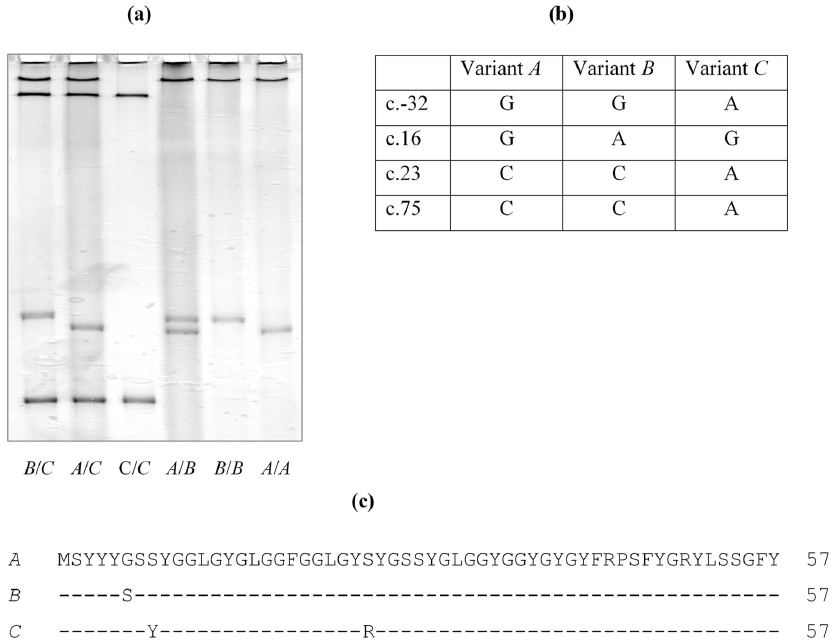
Figure 3. Polymorphism of ovine KRTAP36-1 . ( a ) Three variants ( A to C ) in either homozygous or heterozygous forms were detected by PCR-SSCP. ( b ) Four single nucleotide polymorphisms (SNPs) were found in these variants. ( c ) Three of the SNPs would lead to amino acid changes and result in three di ff erent amino acid